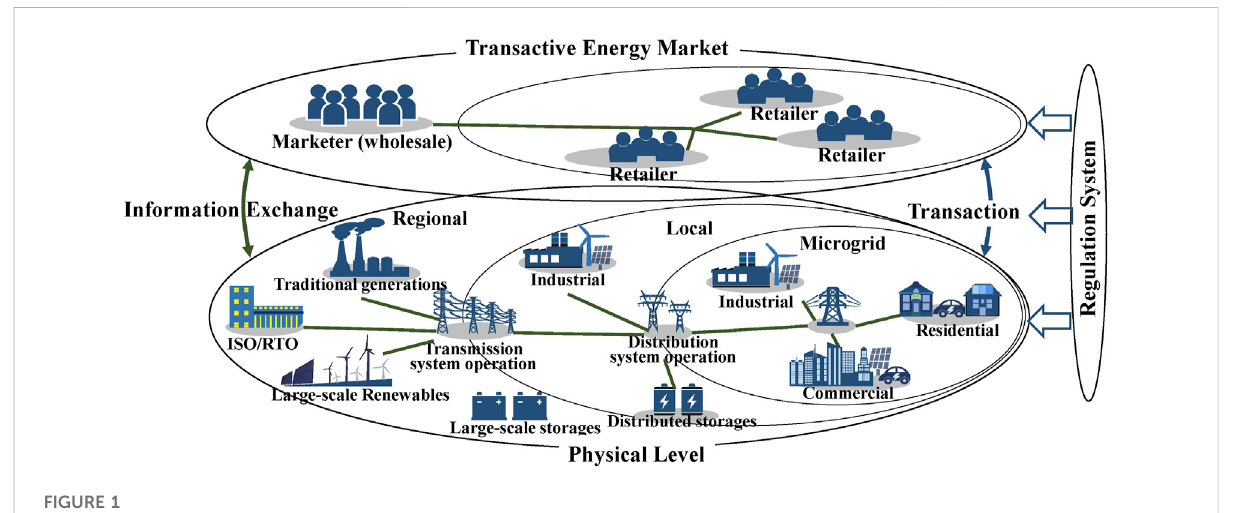
FIGURE 1 Transaction energy system con fi